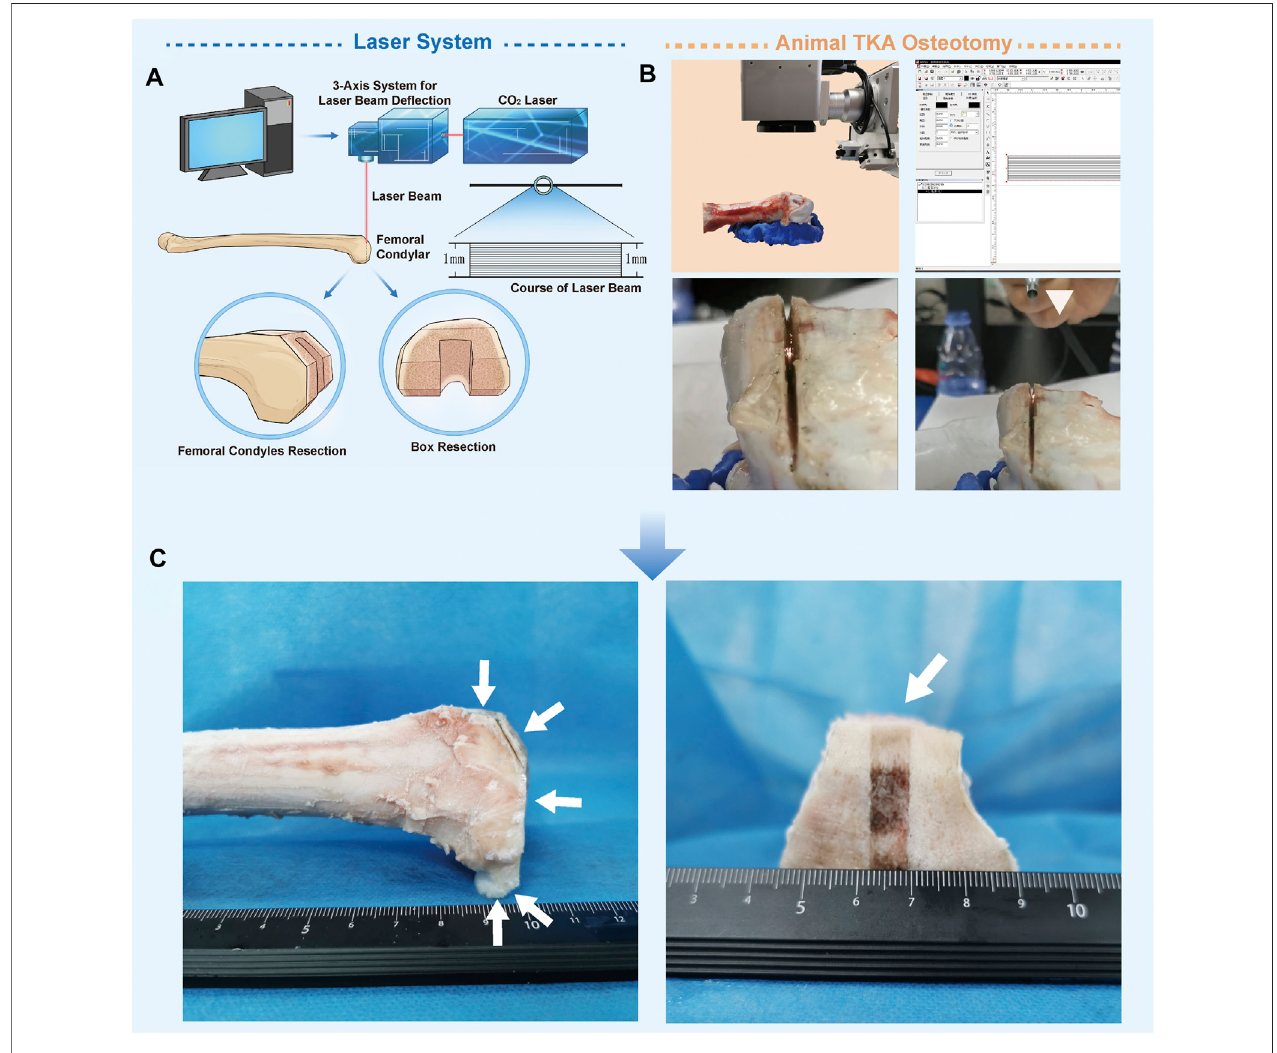
FIGURE 1 | Ultra-pulsed CO 2 laser osteotomy of the distal femur of sheep. (A) Schematic chart of the ultra-pulsed laser CO 2 laser osteotomy system (B) Operational process of the sheep distal femur bone-cutting surface in total knee replacement using this system; the white triangle indicates the self-made water spray device (C) Distal femur after laser